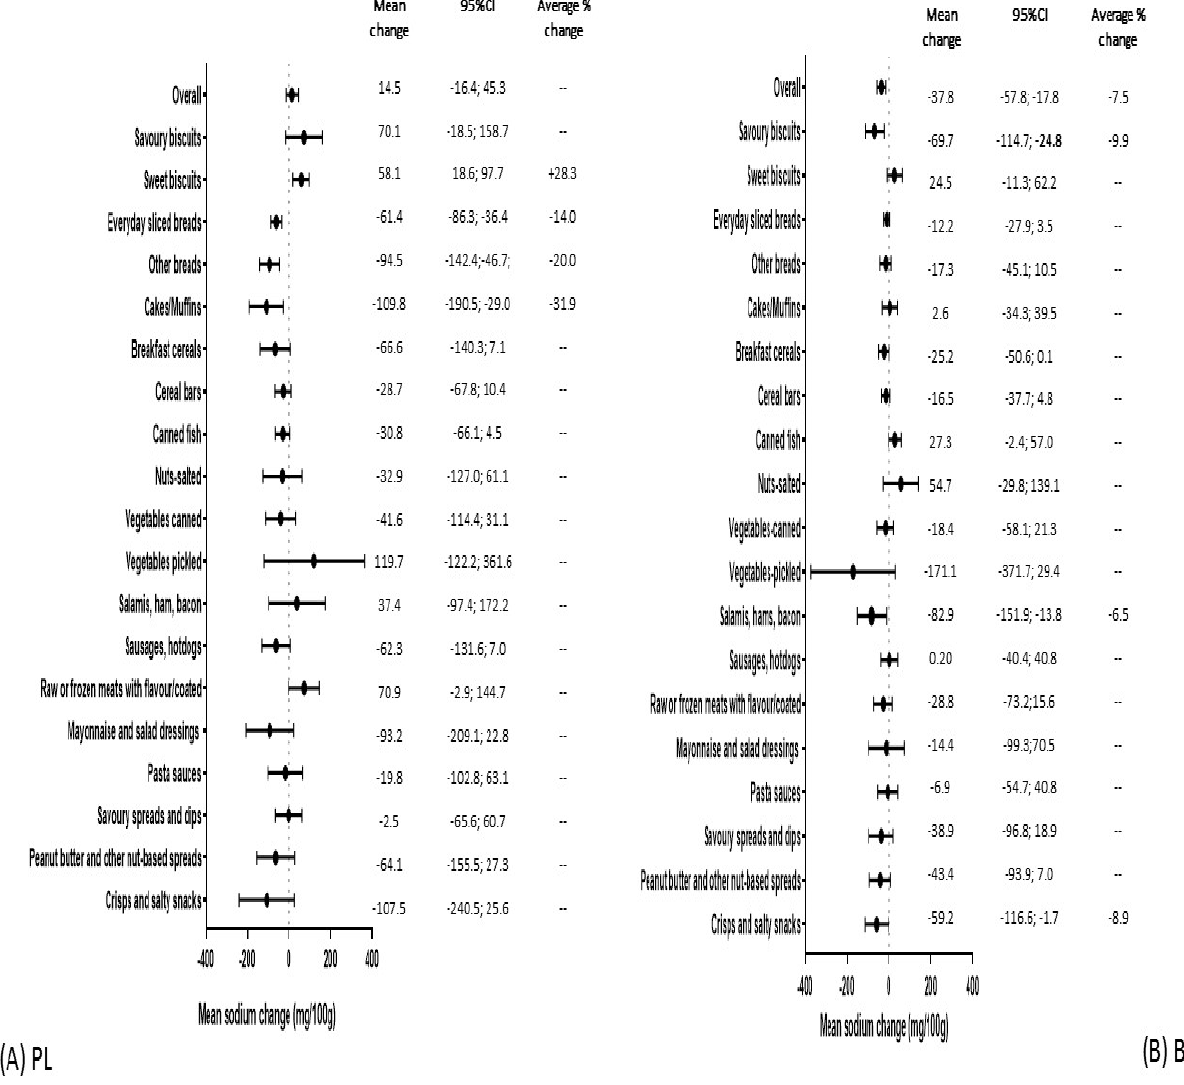
Figure 1. Mean sodium changes in the period 2015–2019 according to brand (overall and by food categories): supermarket private labels ( A ) and branded labels ( B ).